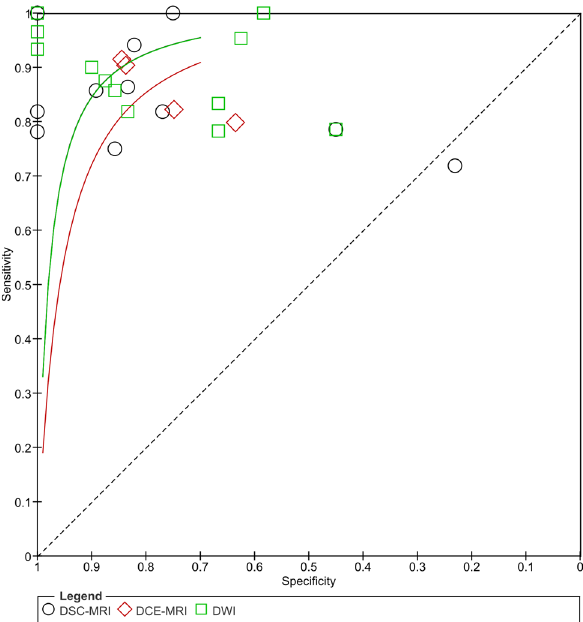
Figure 4. Summary receiver operating characteristics plot comparing diagnostic ability of subgrouped modalities. DSC-MRI, DCE-MRI and DWI are included in the SROC plot and compared according to the mean reported sensitivity and specificity of the studies in the subgroup.